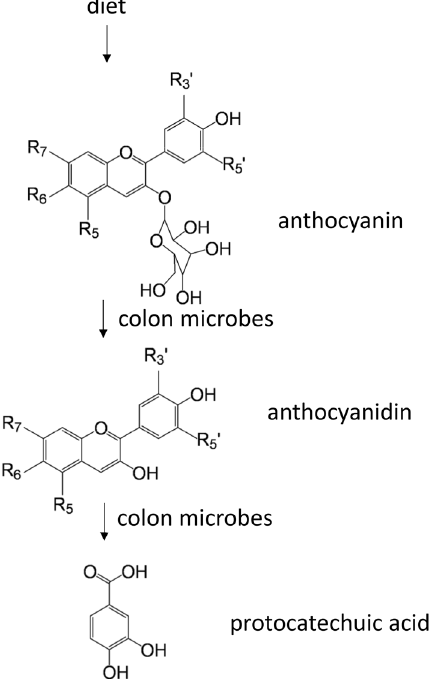
Figure 5. Colon microbes contribute to protocatechuic acid biosynthesis from diet anthocyanins. R 3 ′ =H, OH or OCH 3 ; R 5 ′ =H, OH or OCH 3 ; R 5 =OH or OCH 3 ; R 6 =H or OH; R 7 =OH or OCH 3 . R 5 , R 7 can be glycosylated if it is a